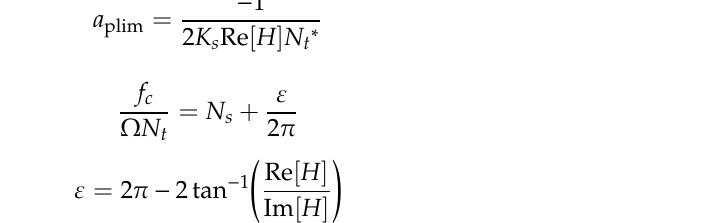
Figure 9. Geometries diagram of the cutting and vibration in the milling process ( a ) in the view of the Z w ‐ direction; ( b ) in the view of the X w ‐ direction.